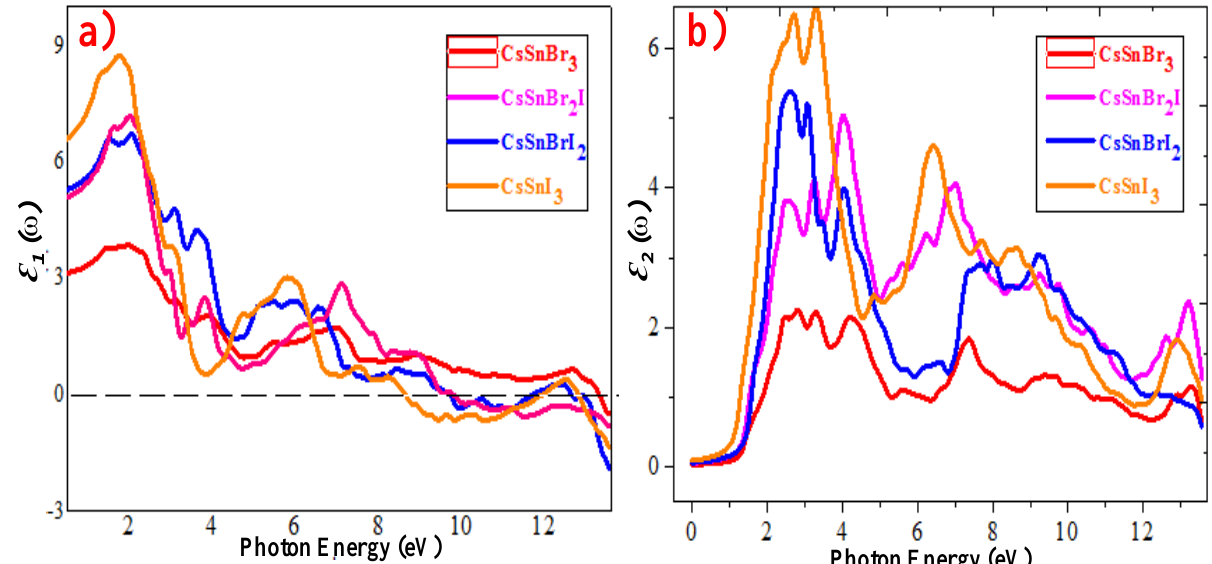
Figure 1. The calculated value of ε 1 (ω) and ε 2 (ω) for CsSnBr 3 , CsSnIBr 2 , CsSnI 2 Br and CsSnI 3 depending on the photon